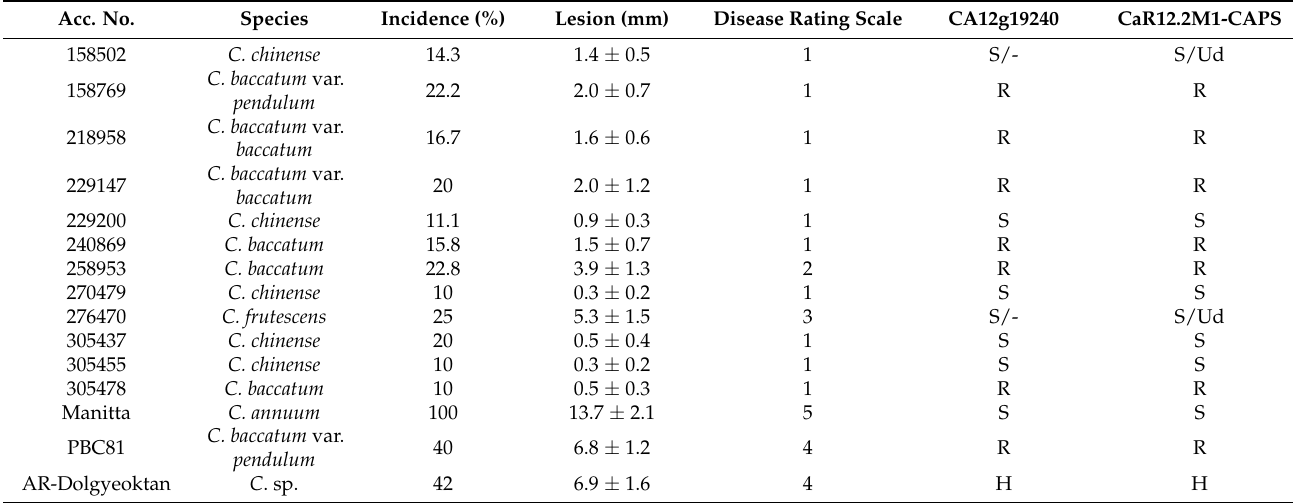
Table 4. Incidence and Reaction to CA12g19240 and CaR12.2M1-CAPS marker of Pepper genetic resources selected with non-wound and wound inoculation.